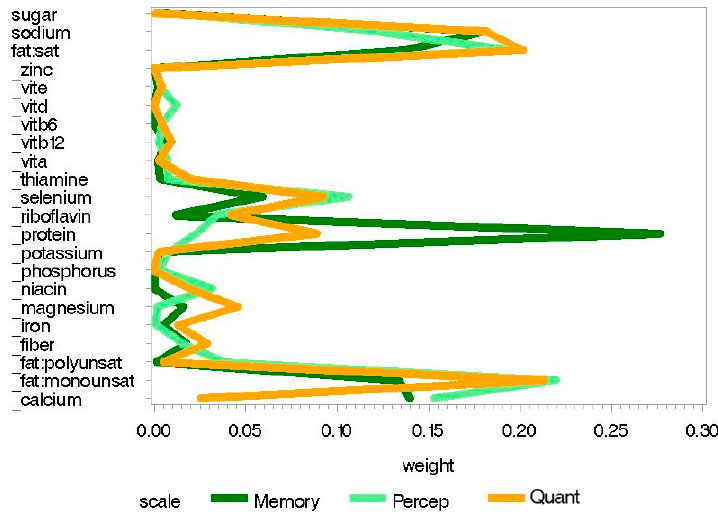
Figure 4. Weight plots for statistically significant scales from the childhood “poor nutrition” index of dietary nutrition intake.